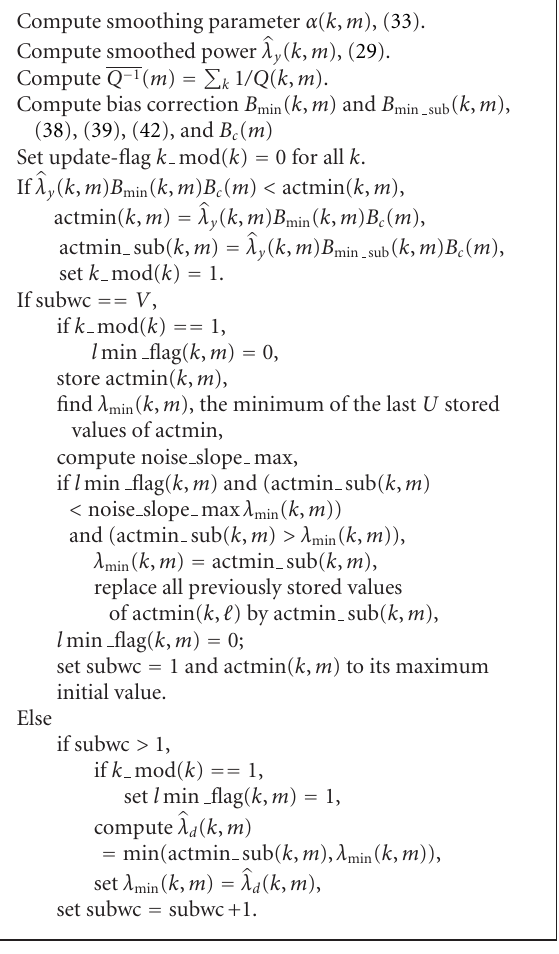
Algorithm 2: The minimum statistics noise estimation